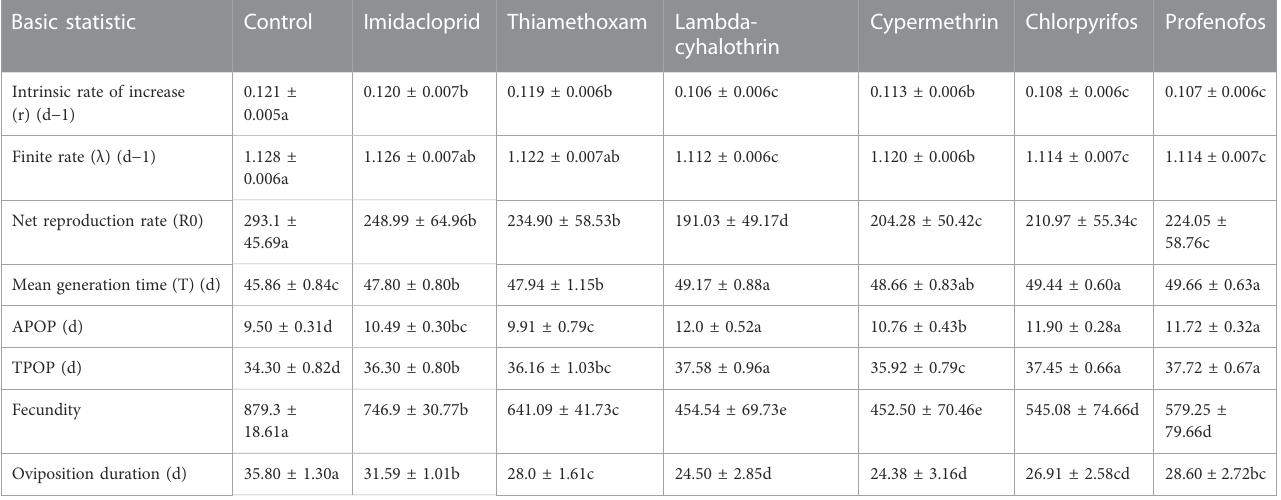
Meanssharingsamelettersinrowsarenotsigni fi cantlydifferentfromoneanotherat p > 0.05.AdultPre-OvipositionPeriod(APOP)offemaleistheintervalfromadultemergenceto fi rstoviposition and the Total Pre-Oviposition Period (TPOP) of female is the duration from egg to fi rst